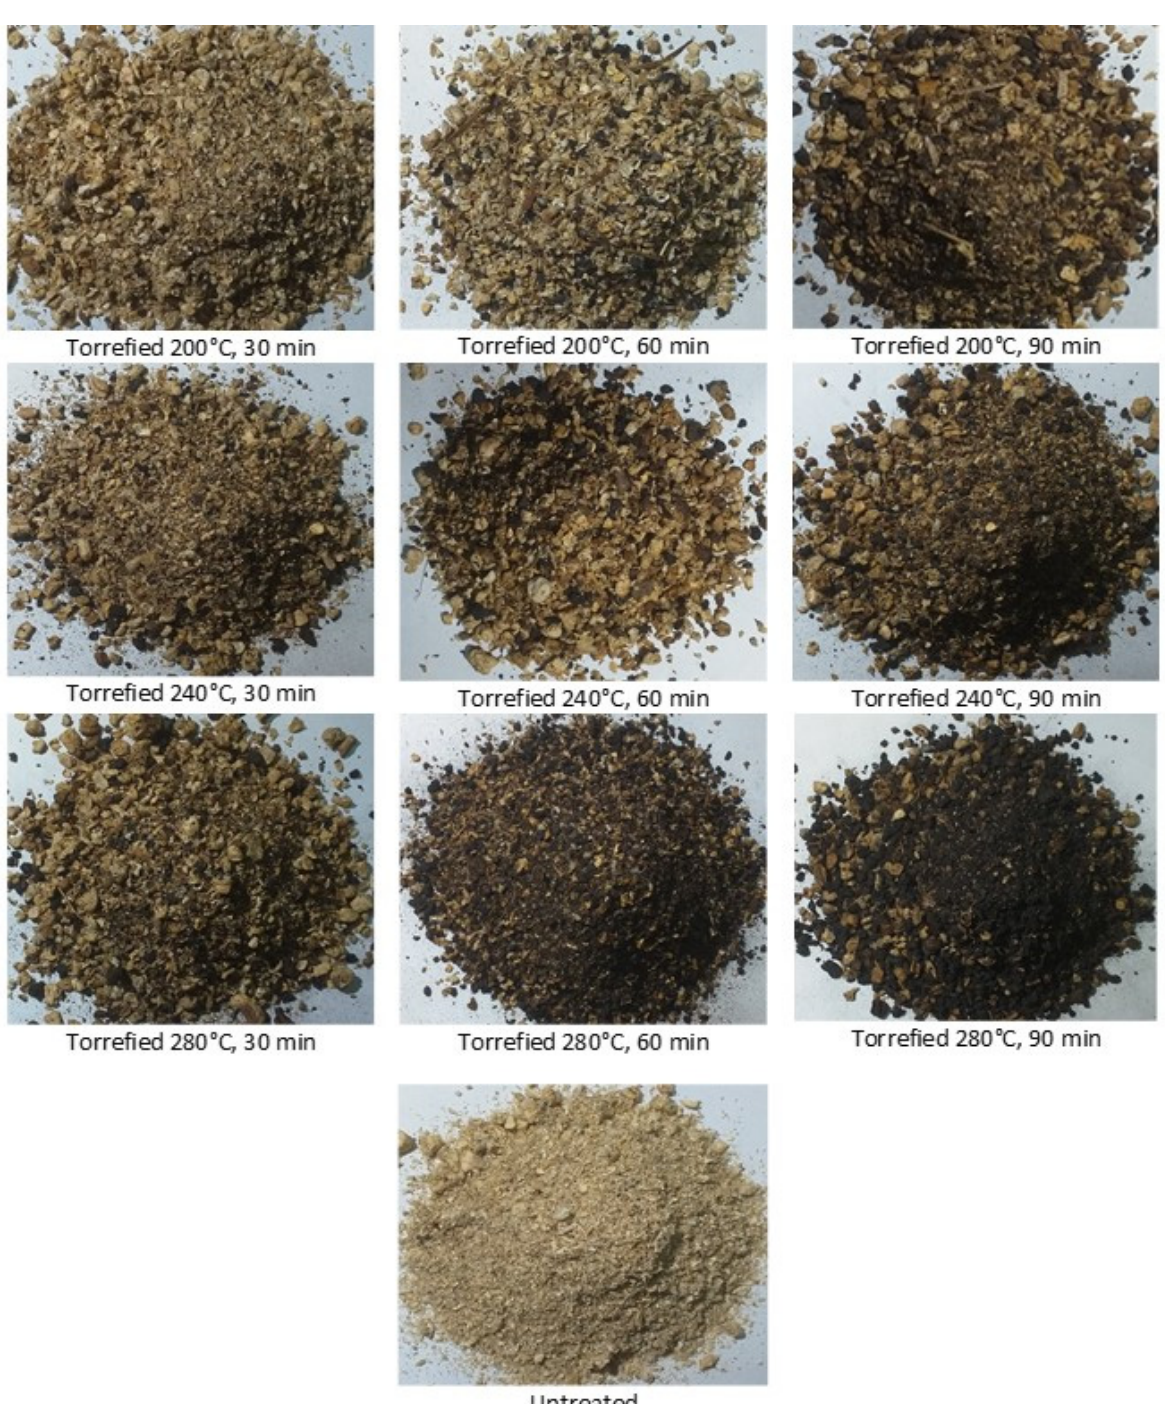
Figure 3. Milled products from untreated corncobs and torrefied corncobs produced under different temperatures and residence